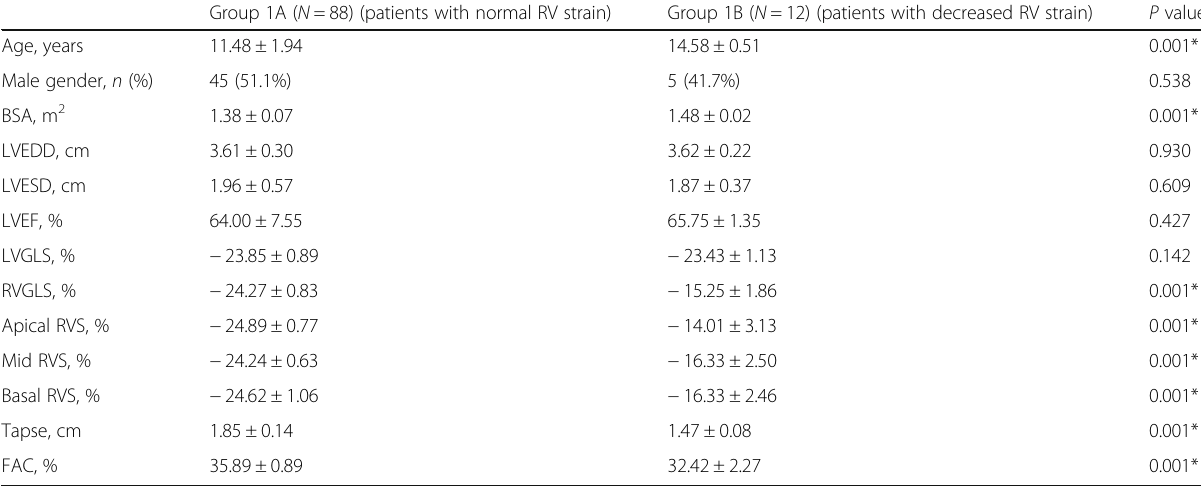
Table 5 Basal characteristics, echocardiographic results, and RV 2DSTE of group 1 subgroups at 29 weeks of receiving chemotherapy Group 1A ( N = 88) (patients with normal RV strain) Group 1B ( N = 12) (patients with decreased RV strain)